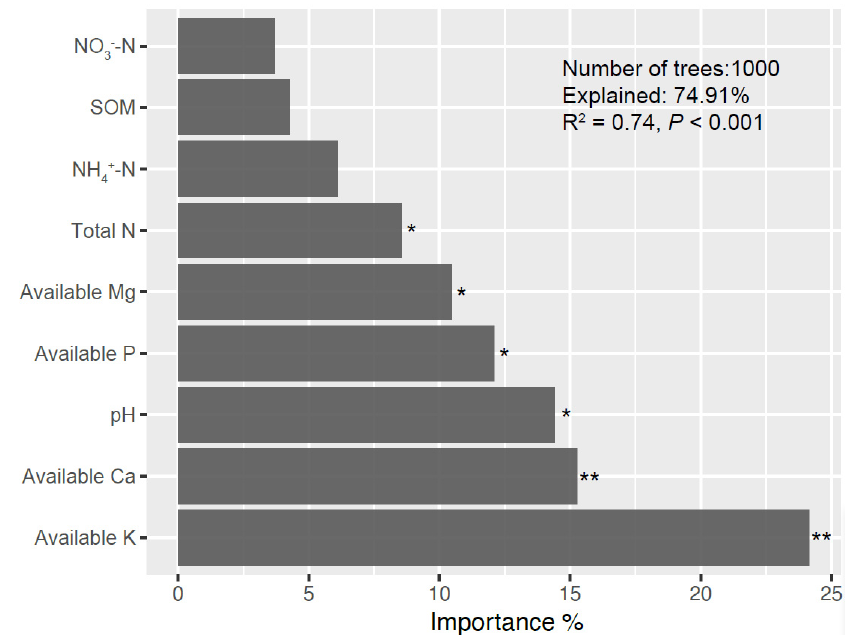
Figure 4. The impacts of soil properties on bacterial community composition by RF analysis. Soil properties are ranked in ascending order of importance to the accuracy of the model. The significance level is indicated by ** ( p < 0.01) and * ( p < 0.05).